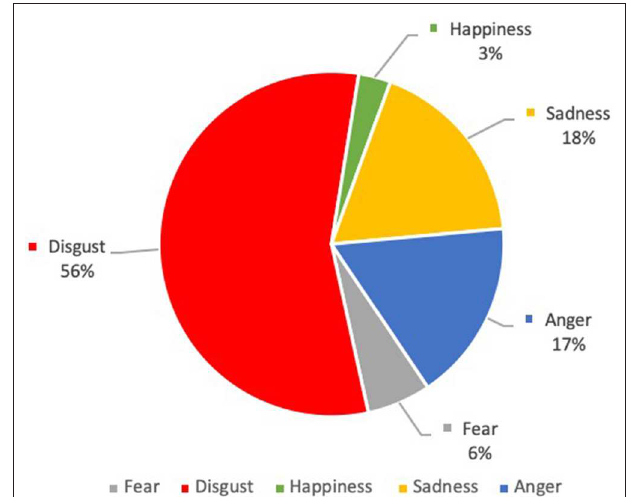
FIGURE 8 | Reactive sadness.